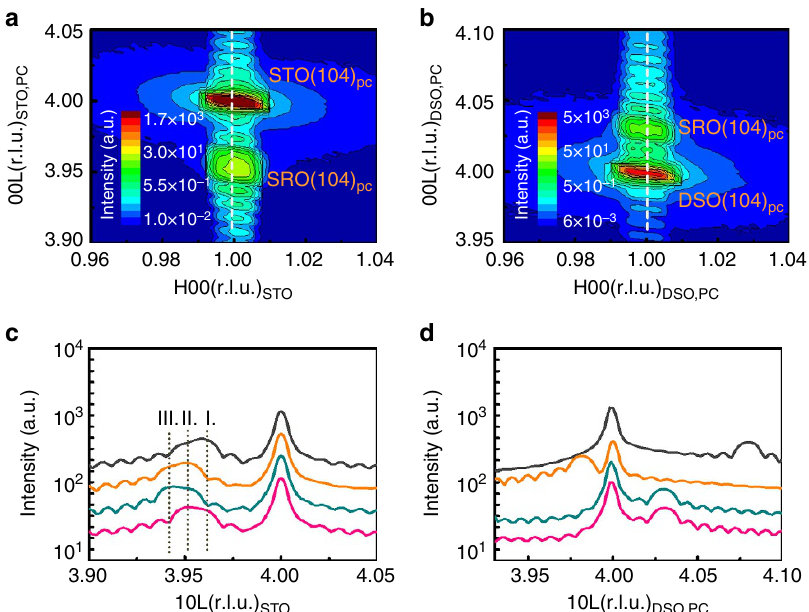
Figure 4 | The reciprocal space maps of SrRuO 3 /SrTiO 3 and SrRuO 3 /DyScO 3 . The reciprocal space maps were taken around the (104) reflection of ( a ) SrTiO 3 and ( b ) DyScO 3 . The corresponding radial scans along the horizontal vector, H ¼ 1 (the vertical dashed lines), with four orthogonal angles, f ¼ 0 o (black line), 90 o (green line), 180 o (orange line) and 270 o (red line), were collected to inspect the domain structures of SrRuO 3 thin films grown on ( c ) SrTiO 3 and ( d ) DyScO 3 substrates, respectively. In ( c ), the shift in peak due to the tilted angle along the a axis of SrRuO 3 is labelled as I and III. Position II represents diffraction characteristics from the b axis of SrRuO 3 .